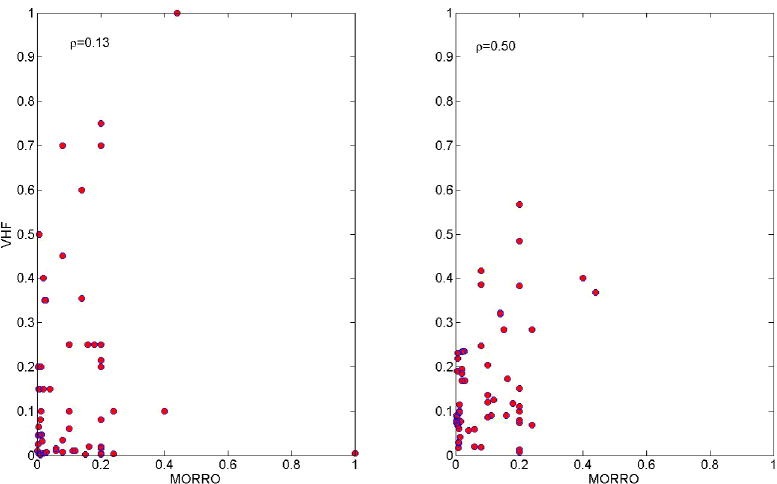
Figure 3. For each cycle and each PMSE layer in a cycle we plot the corresponding maximum PMSE values for the two radars. The left panel shows all points where both VHF and MORRO observe a layer. The scales are normalized by putting the largest maximum equal to 1 for both radars. In the right panel we have done a running mean over three data points. The linear correlation coefficient ρ is given for each case.